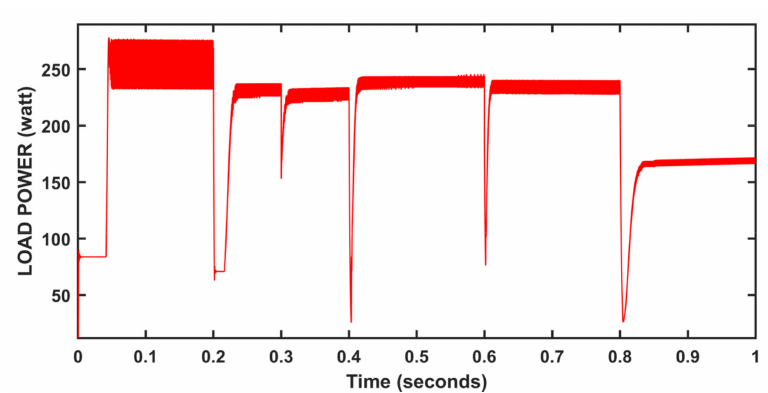
Figure 36. Performance at variable temperatures and varying